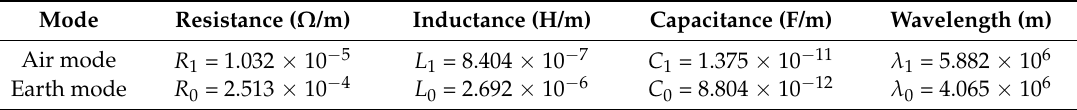
Table 4. Parameters of different modes.